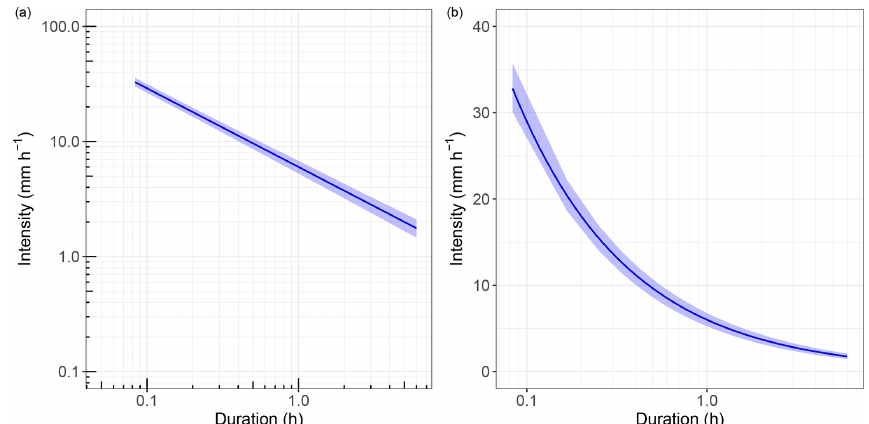
Figure 11. (a) Log–log and (b) semi-log plot of the threshold absolute variability. The blue line is the rainfall threshold obtained using the mean value of a and b (Table 3). The shaded area represents the threshold absolute variability whose upper and lower bounds have been computed considering the 2 . 5 and 97 . 5 percentiles of the intensity distributions for fixed durations.